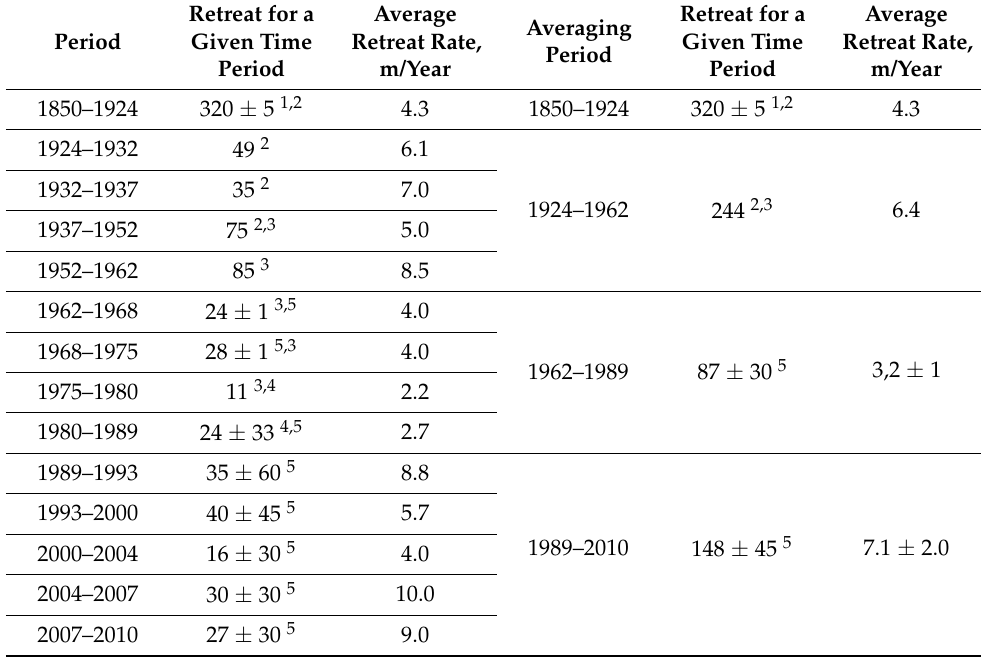
Figure 17. The edge of the Maashei glacier, September 2022. Table 9. Retreat of the tongue of the Bolshoi Maashei